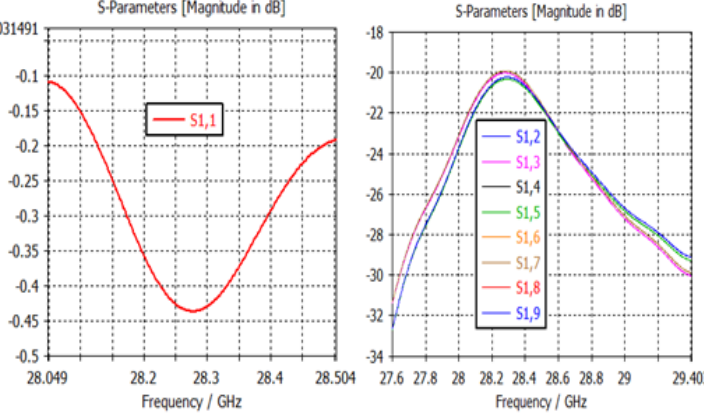
Figure 11. S-parameters obtained from the time-domain simulation.